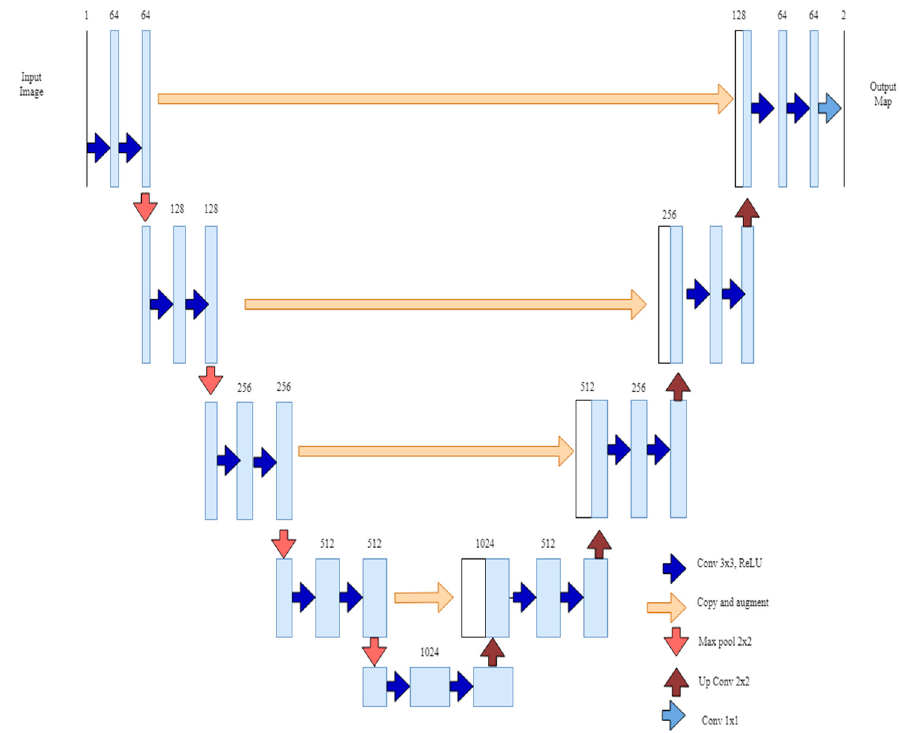
Figure 3. U-Net Convolutional Architecture. Table 1. FCRN and U-Net Results.